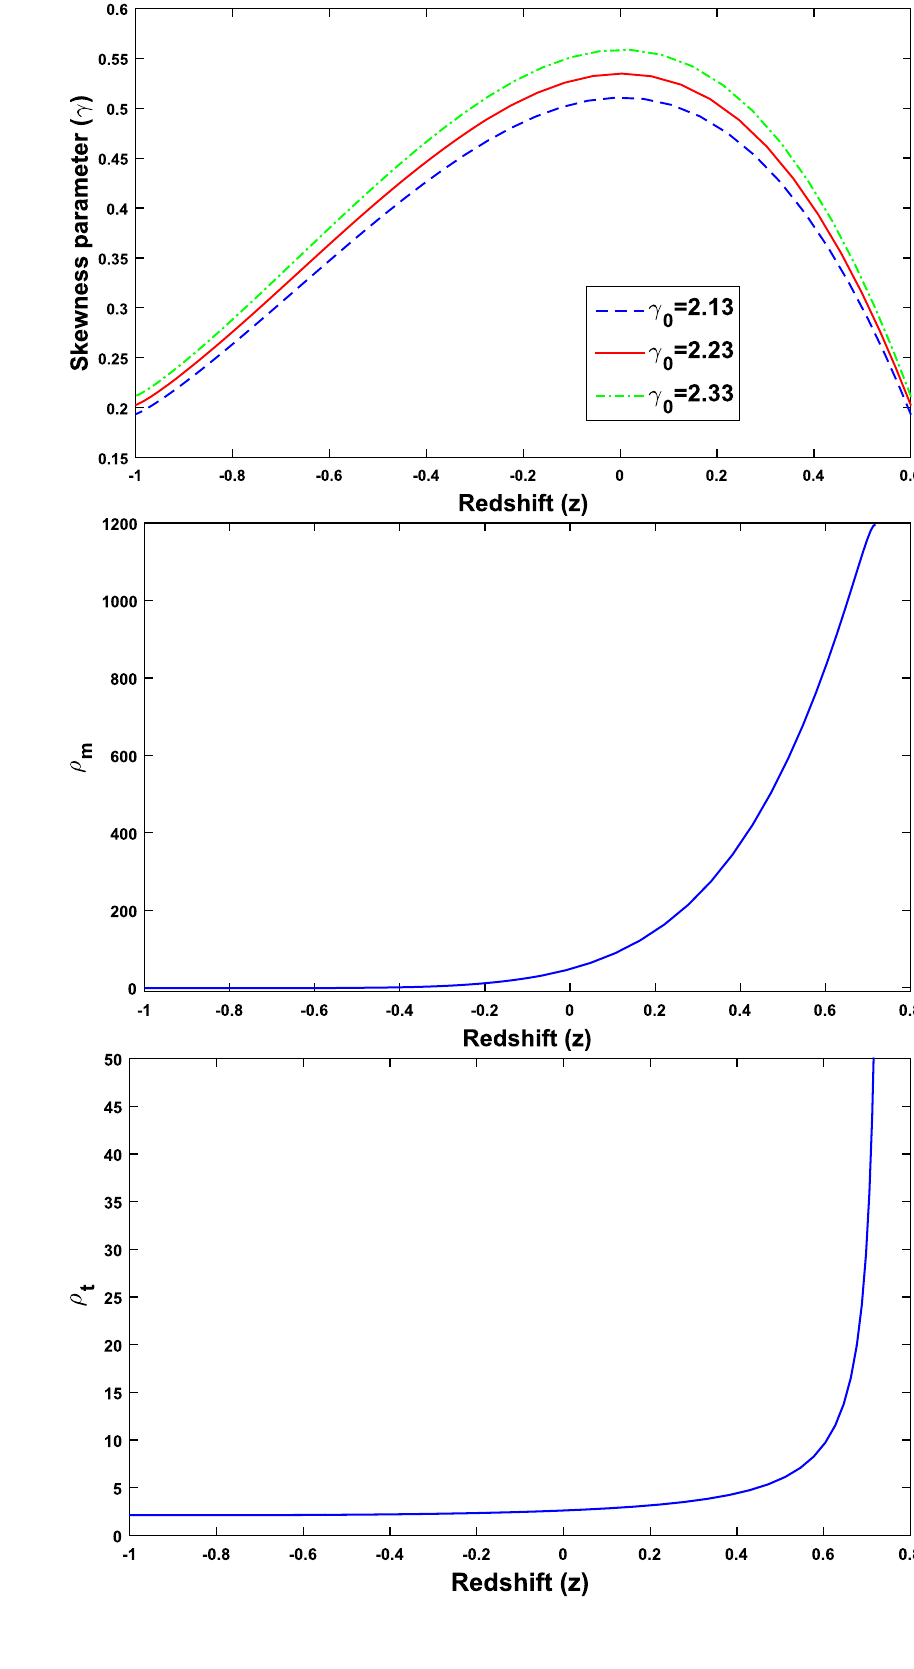
Fig. 3 Plot of energy density ( ρ t ) of THDE versus redshift ( z ) for c 1 = 0 . 01, c 2 = 0 . 115, k = 0 . 325, γ 0 = 2 . 13, δ = 2 . 5 and α = 1 .